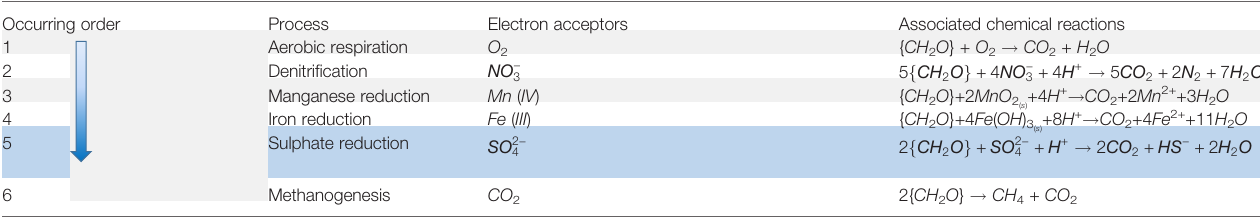
TABLE 1 | Possible redox reactions as biodegradation process that together may describe the formation of the toxic H 2 S. Occurring order